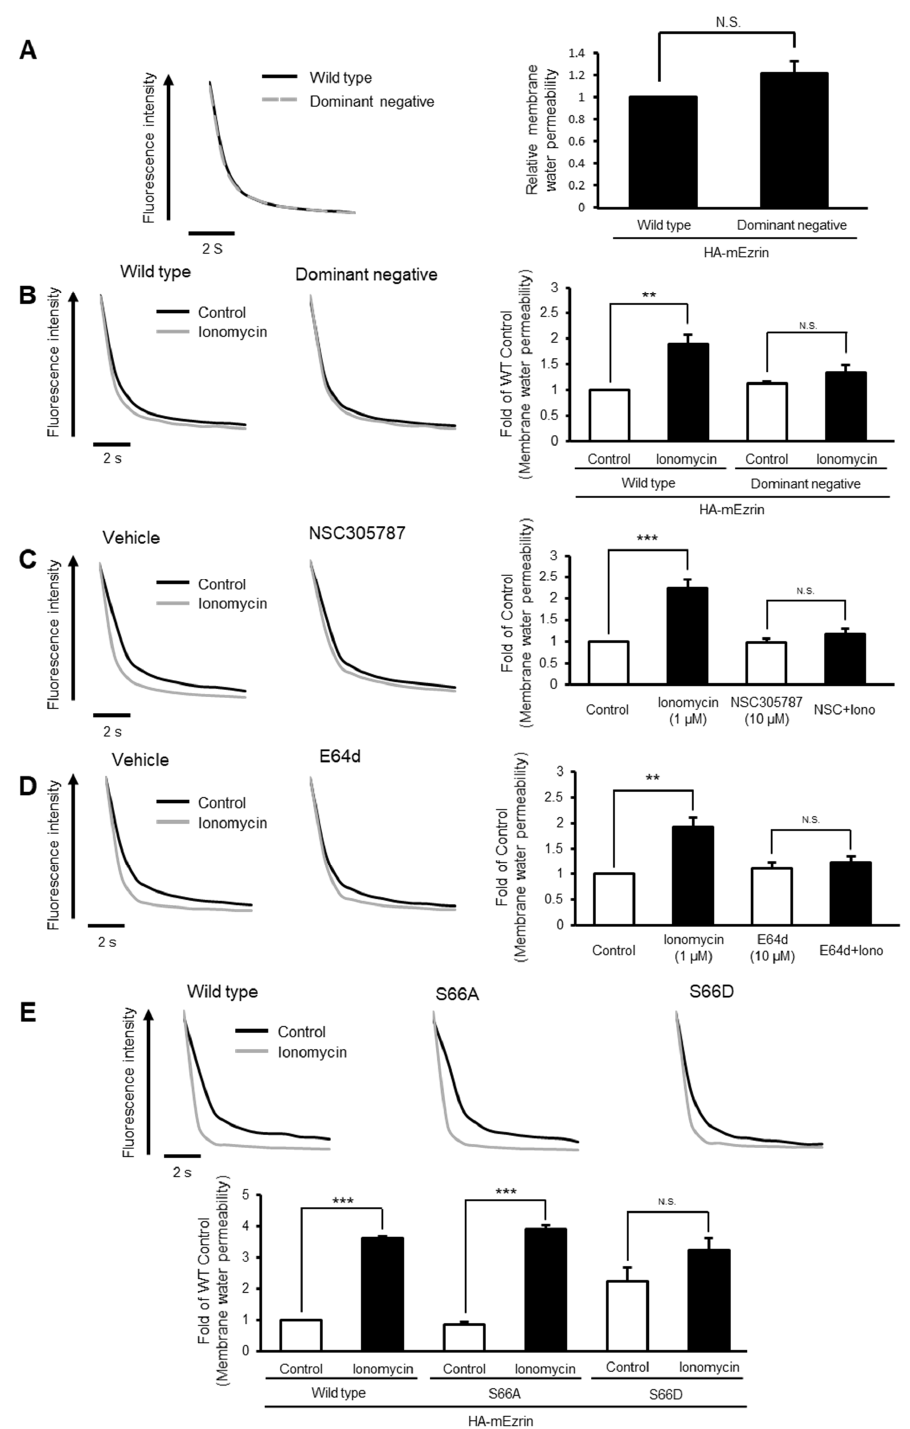
Figure 3. Ezrin inhibition attenuates the ionomycin-induced increase in membrane water permeability in MLE-12 cells. MLE-12 cells were transfected with wildtype or dominant negative (lacking actin-binding domain) ezrin, after which water permeability of plasma membrane was measured by the calcein fluorescence quenching method ( A ) . Cells were transfected with wildtype or dominant negative ezrin. The cells were treated with ionomycin (1 µ M) for 15 min ( B ) or cotreated with ionomycin (1 µ M) and NSC305787 (10 µ M) ( C ). Cells were pretreated with E64d (10 µ M) for 30 min and then treated with ionomycin (1 µ M) for 15 min ( D ). MLE-12 cells were transfected with wildtype, S66A, or S66D (uncleavable mutant) ezrin and then treated with ionomycin (1 µ M) for 15 min ( E ). Data represent the mean ± S.E. ( n = 3–4). ** p < 0.01 and *** p <